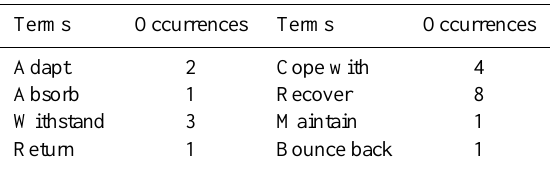
Table 1. Terms used in the definitions of resilience in rela- tion to natural hazards, according to the definitions selected in Mayunga